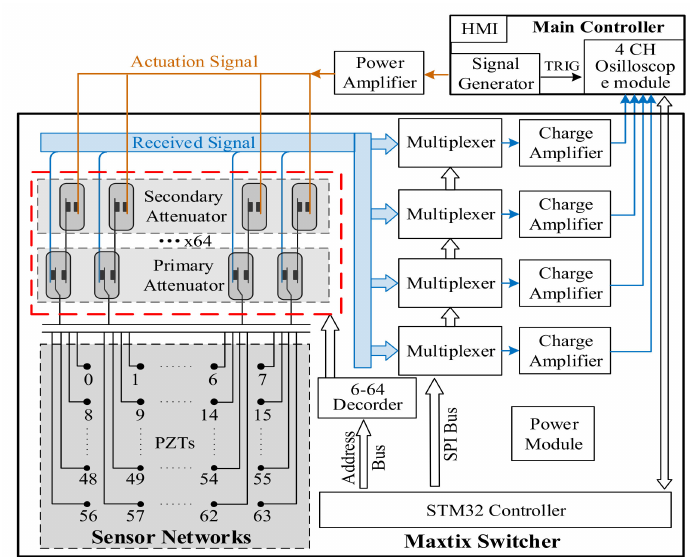
Figure 4. Design diagram of the hardware in the